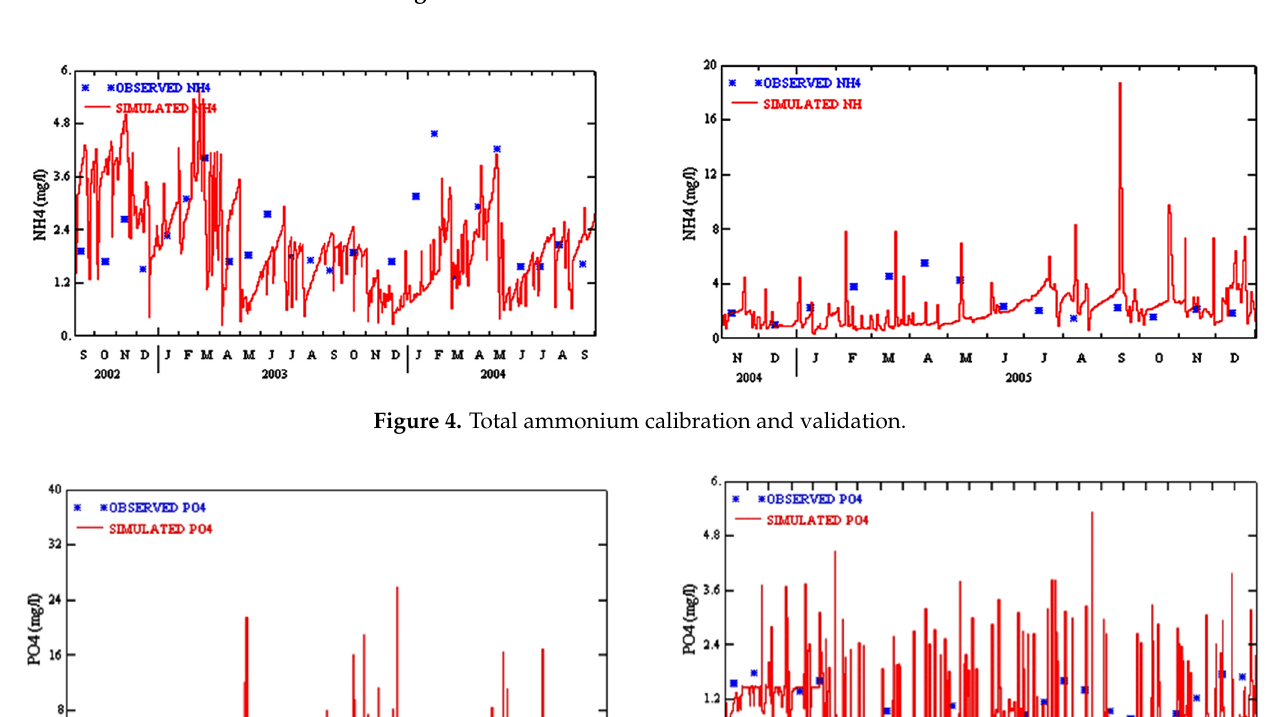
Table 7. Water quality calibration and validation statistical results